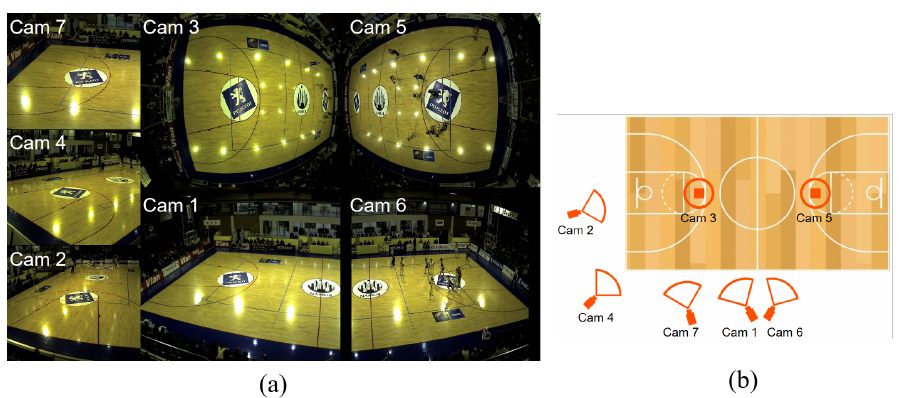
Figure 6. APIDIS basketball dataset is captured by five ground cameras around the court and two fish-eye cameras overhead of the court: ( a ) images captured from seven views; ( b ) the schematic diagram of camera